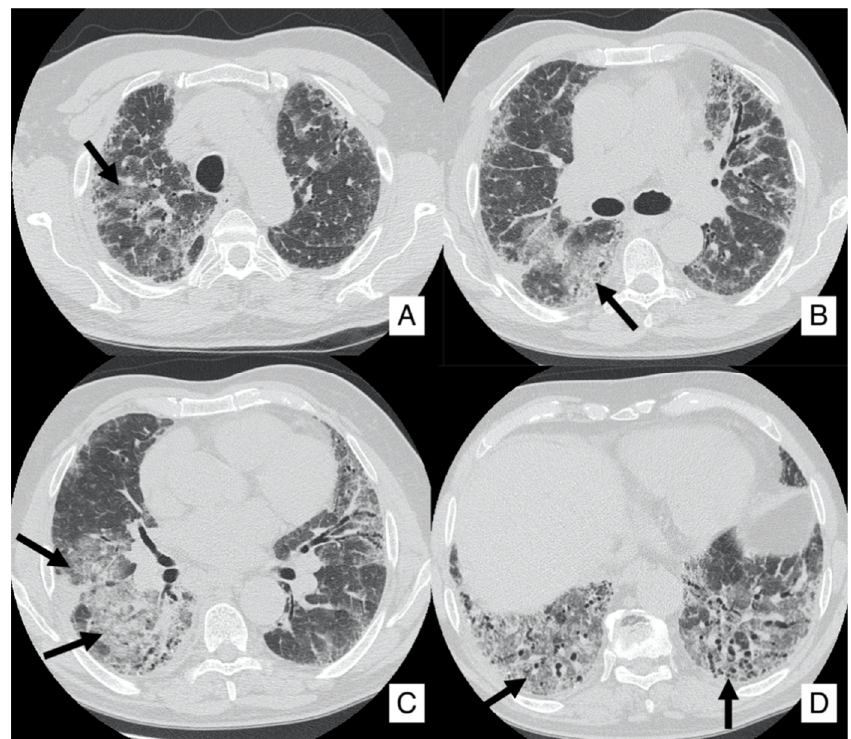
Figure 9. Acute exacerbation of IPF in an 80-year-old man (A,B,C). These CT scans demonstrate an increased diffuse ground-glass opacity with an increased parenchymal density, especially in the right upper lobe (black arrows in A and B ) and in the upper part of the right inferior lobe (black arrows in C). At the pulmonary bases, traction bronchiectasis is clearly recognized (black arrows in D). This increased GGO pattern is related to an acute exacerbation of IPF. At clinical evaluation, a decreased vesicular murmur and wheezes in the basal-middle areas were